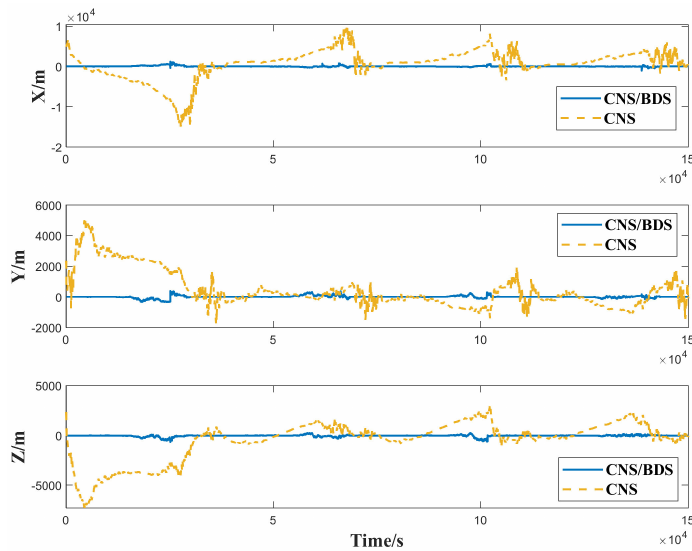
Figure 8. Position error in three directions.